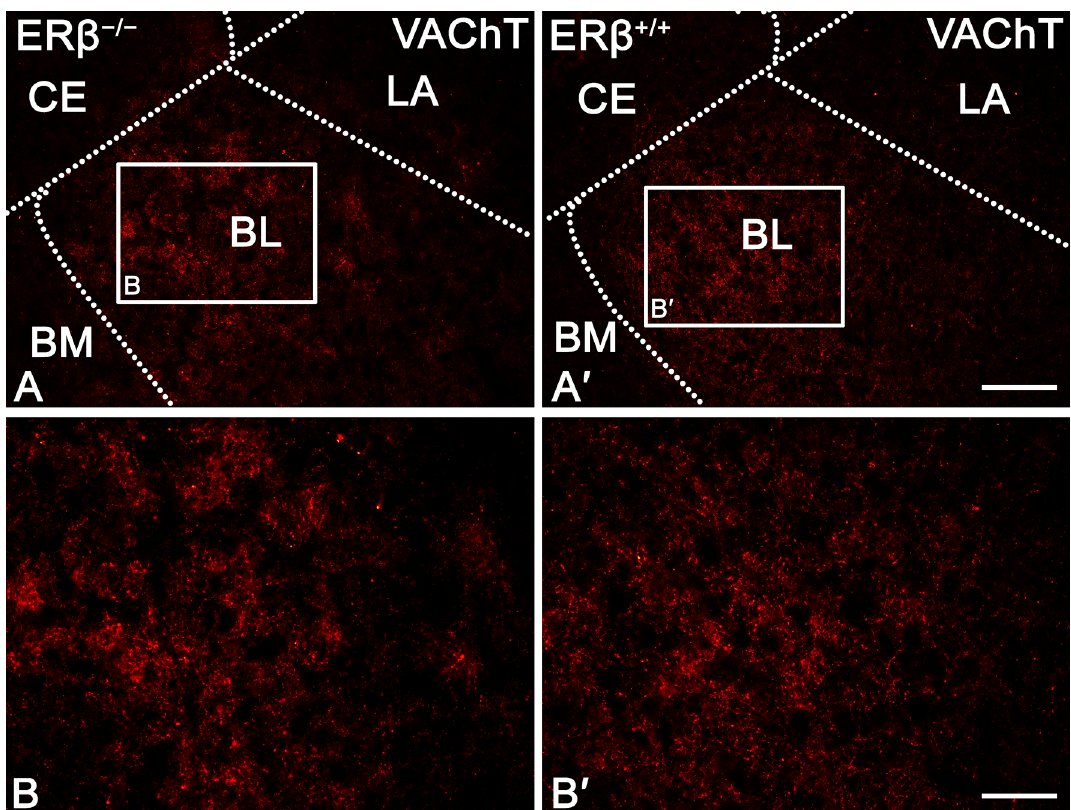
Figure 7. Representative colour photomicrographs illustrating the staining pattern of vesicular acetylcholine transporter (VAChT) in the amygdala of ERβ knock-out (ERβ −/− ) and wild-type (ERβ +/+ ) mice, n = 6 per group. ( A , B ) ERβ −/− mice. ( A ′ , B ′ ) ERβ +/+ mice. Note similar density and signal intensity of VAChT in ERβ −/− ( A , B ) and ERβ +/+ mice ( A ′ , B ′ ). LA—lateral nucleus, BL—basolateral nucleus, BM—basomedial nucleus and CE—central nucleus. The scale bar applies to all microphotographs, and it corresponds to the length of 100 µm in ( A , A ′ ), and 50 µm in ( B , B ′